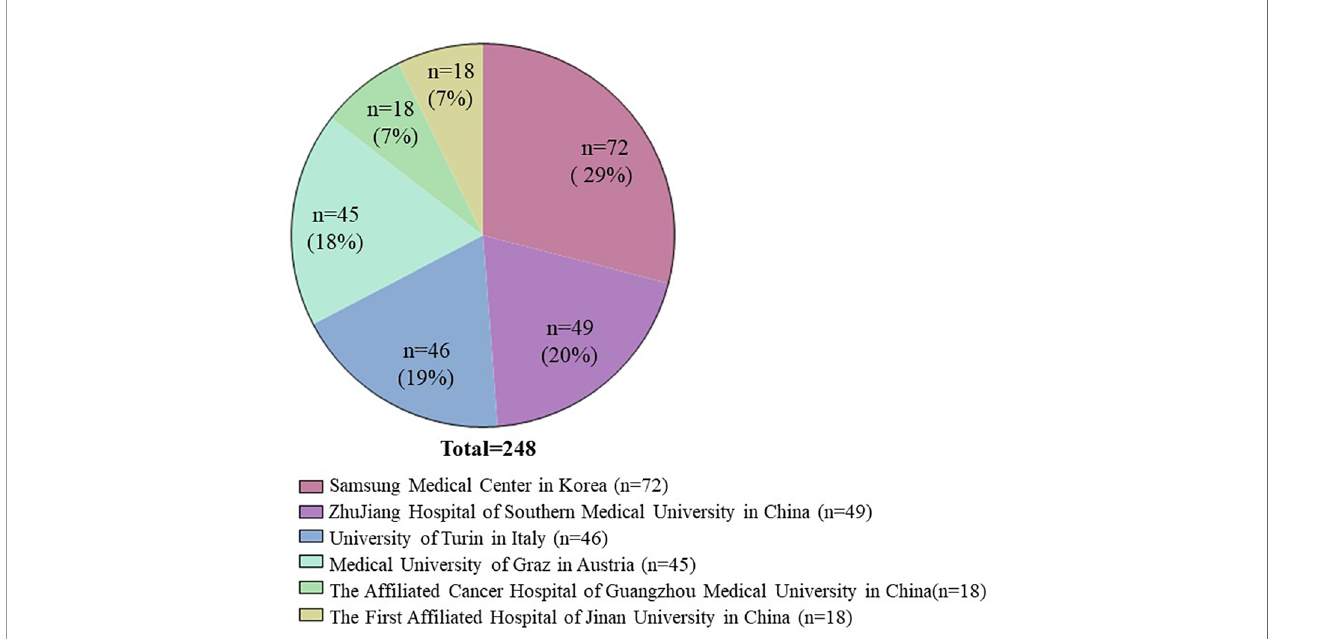
FIGURE 1 | The percentage of patients participating in each